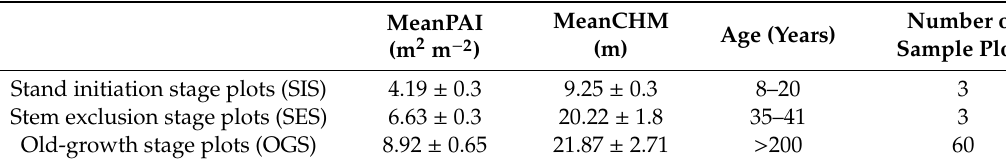
Table 1. Means and standard deviations of the PAI, the canopy height, and the age.